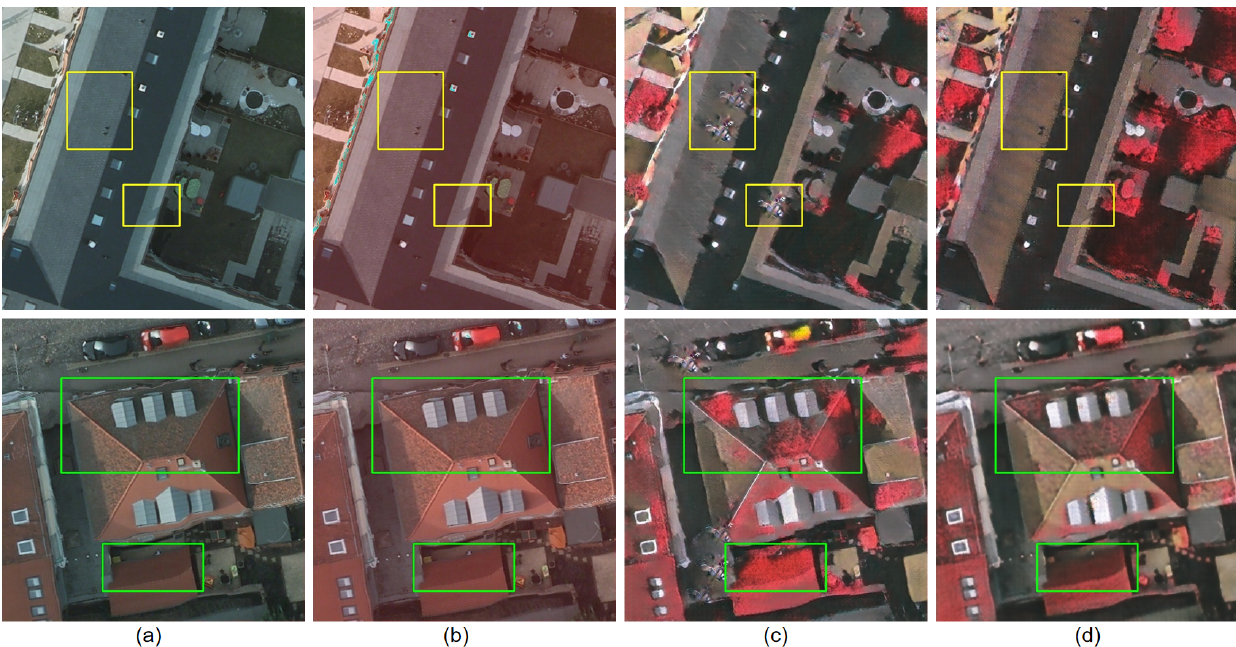
Figure 15. Potsdam to Vaihingen: Original Potsdam images and the transformed images which are used to train the classifier for Vaihingen images. ( a ) Potsdam images. ( b ) Color matching. ( c ) CycleGAN. ( d ) BiFDANet (ours).